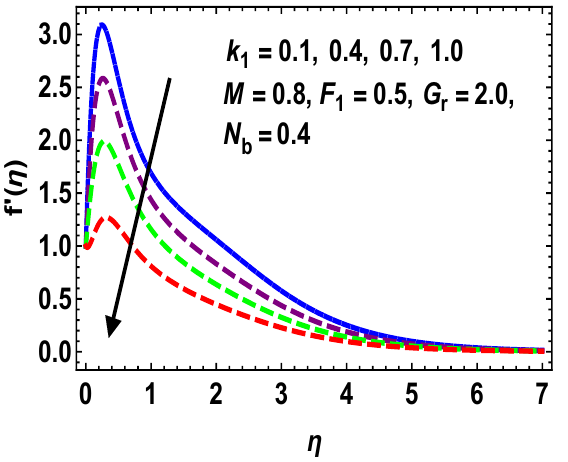
Figure 7. Outcomes of f (cid:48) ( η ) for k 1 where blue, purple, green, and red lines represent for k 1 = 0.1, k 1 = 0.4, k 1 = 0.7, and k 1 = 1.0 respectively.